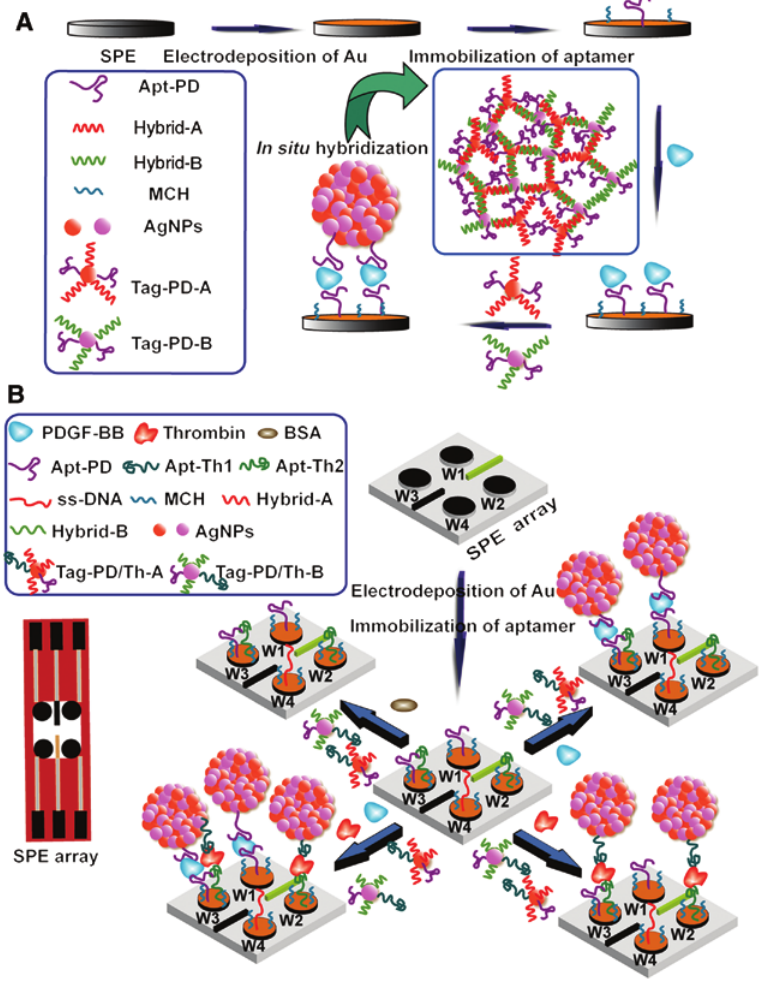
Figure 3: Scheme of the (A) electrochemical detection and (B) multiplexed electrochemical detection of proteins. Reprinted with permission from (Song et al. 2014a). Copyright (2014) American Chemical